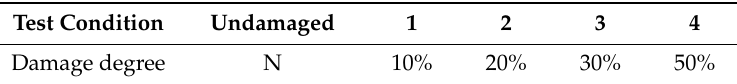
Figure 1. Size of the beam: ( a ) Cross-sectional view of the beam; ( b ) Distribution of the sensors. Table 3. Test conditions (element 4).